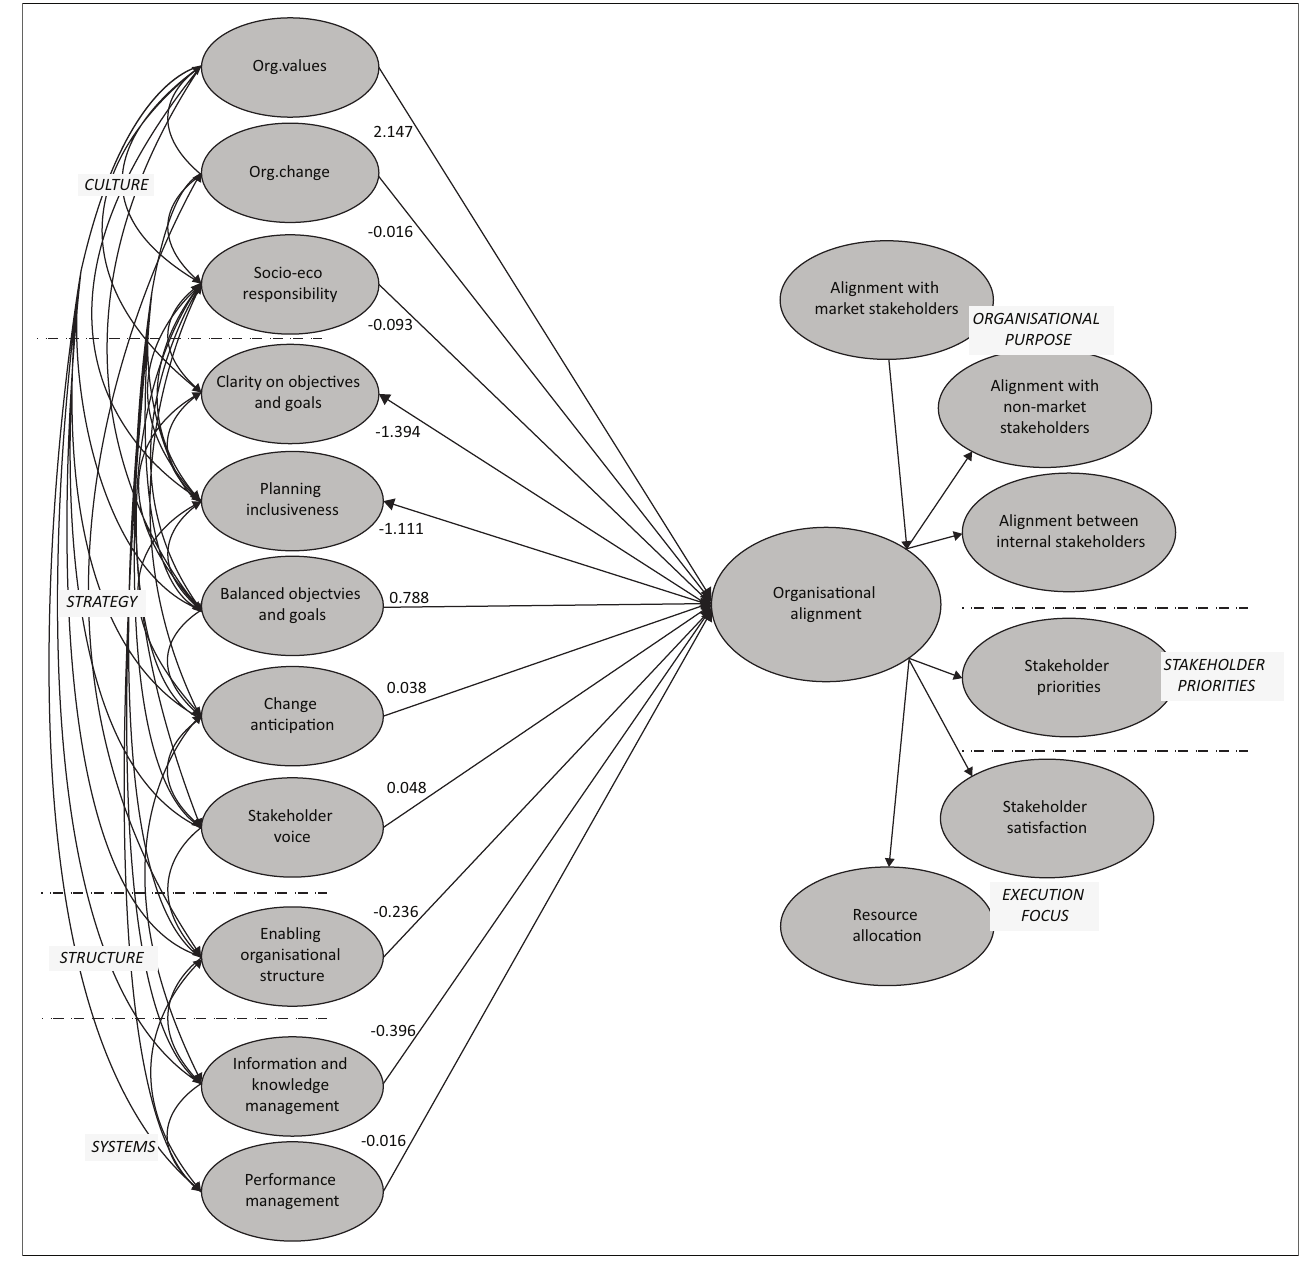
FIG URE 3: Standardised regression coefficients of organisational alignment enabling factors on perceived organisational